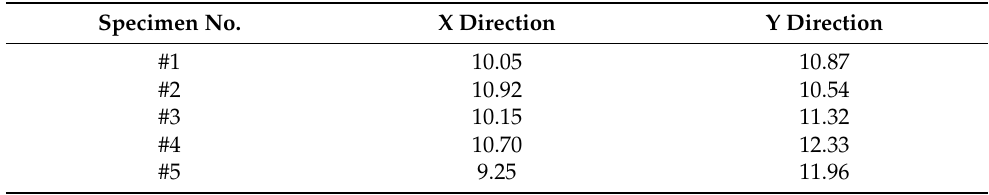
Table 1. JRC of rock fractures along x and y directions. Specimen No.